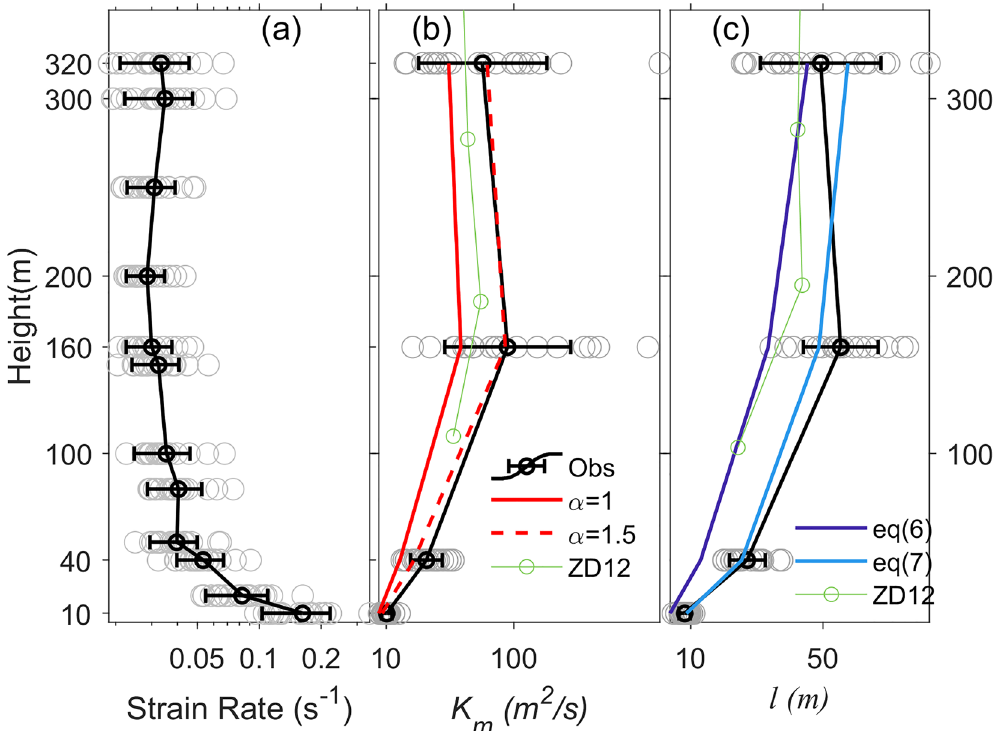
Figure 8. Vertical profiles of ( a ) strain rate, ( b ) vertical eddy diffusivity K m , and ( c ) vertical mixing length l . The average values and standard deviations (error bars) are also shown. Panels ( b ) and ( c ) also show the best fit lines. ZD12 denotes Zhang and Drennan (2012).